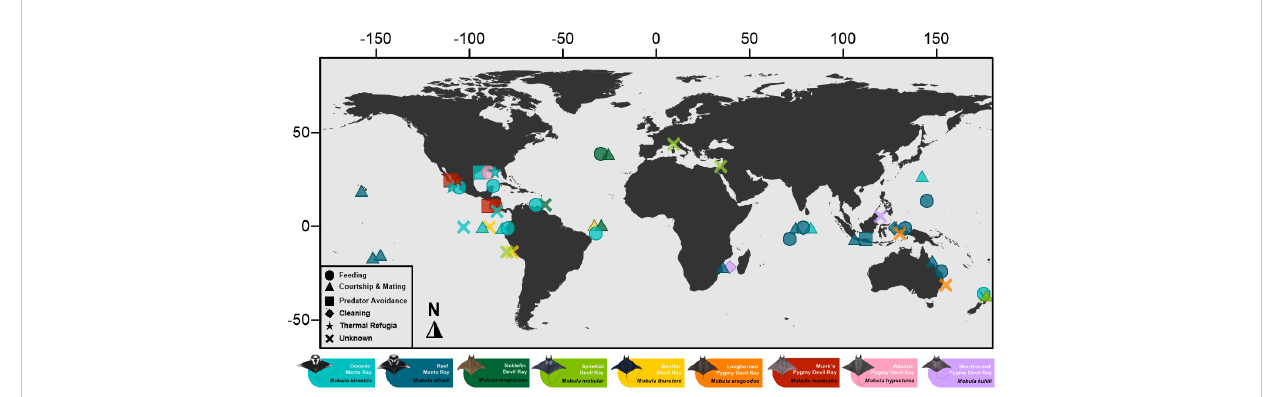
FIGURE 2 Manta and devil rays aggregation sites worldwide by species (colors) and drivers of the aggregation or social group (geometric fi gure). Aggregations illustrated with an X have no information related to the purpose of the